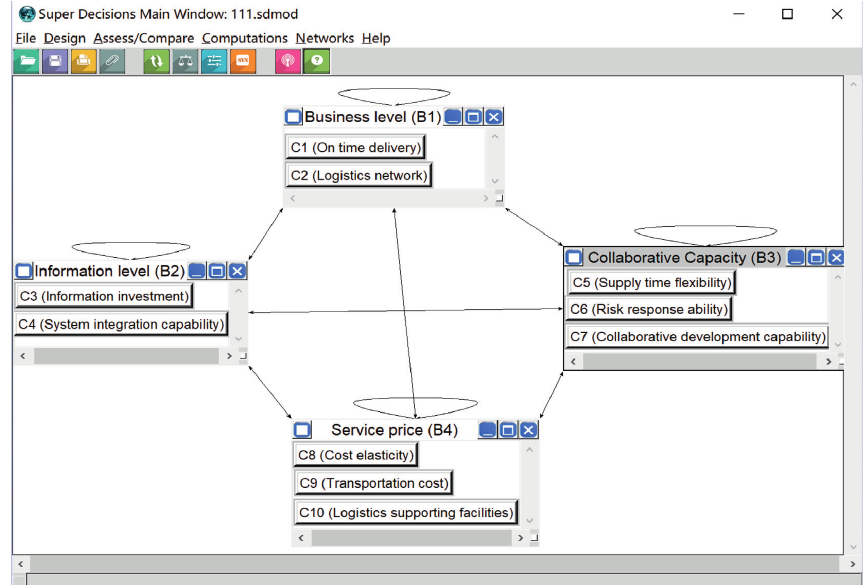
Figure 3: The network structure diagram of the evaluation index system for cruise ship supply LSPs.